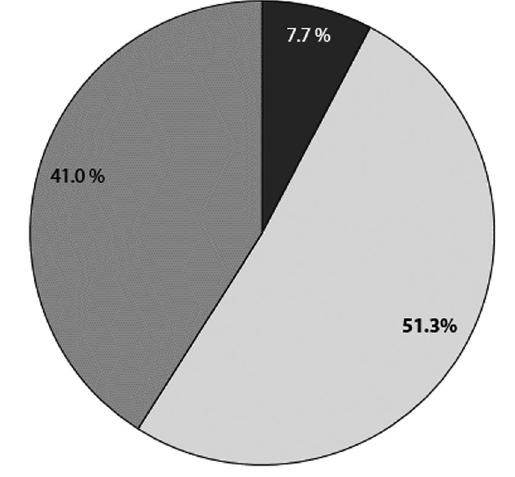
Figure 1: Categorisation of DREEM overall scores.